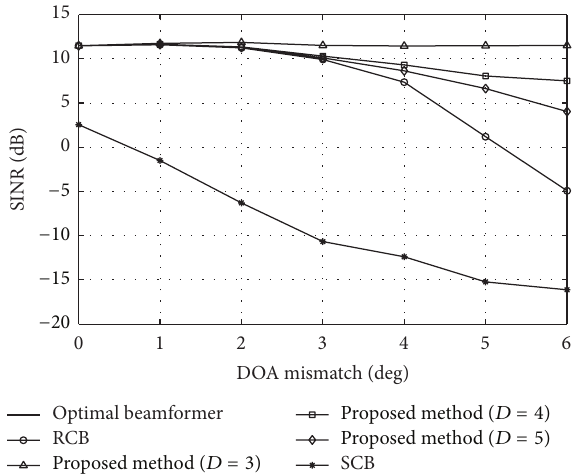
Figure 3: Output SINR of the beamformers versus DOA